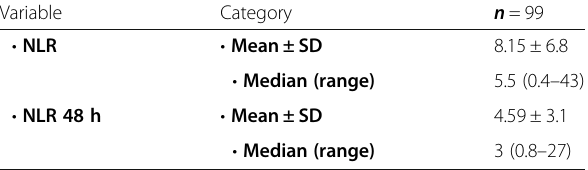
Table 2 Neutrophil/lymphocytic ratio of the studied sample Variable Category